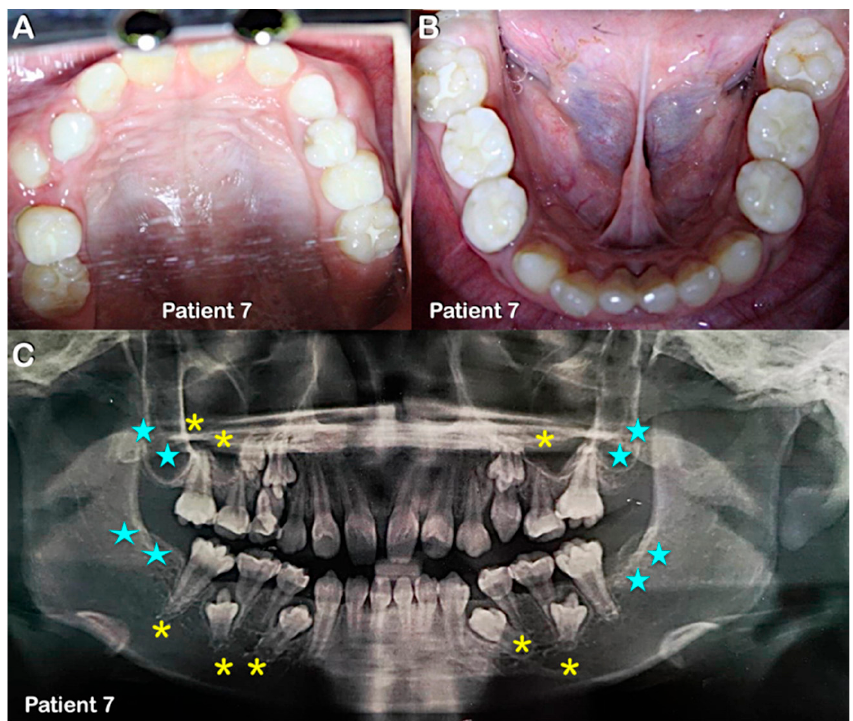
Figure 6. Patient 7 in mixed dentition. ( A , B ) Round-shaped permanent molars and molars with multiple supernumerary cusps. ( C ) Panoramic radiograph showing agenesis of second and third permanent molars (blue stars) and single-rooted primary and permanent molars (yellow asterisks).